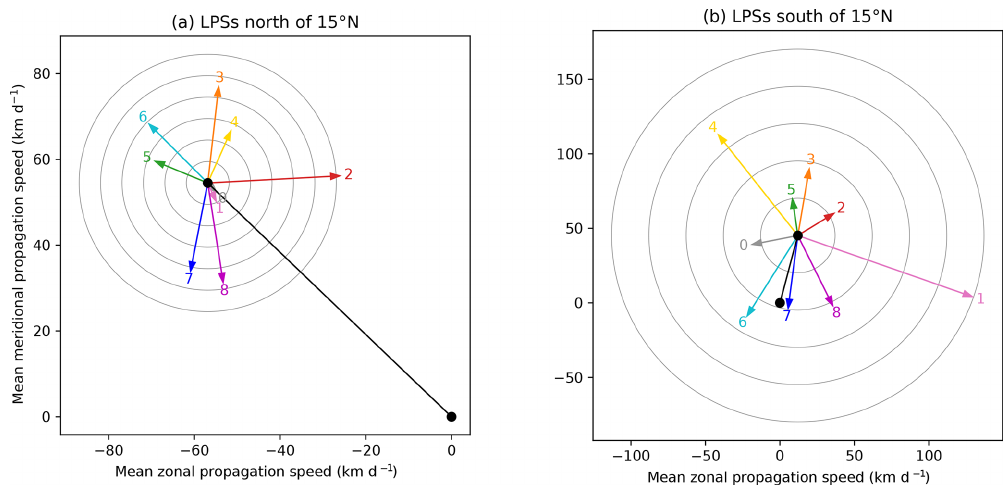
Figure 5. The effect of the BSISO on monsoon LPS propagation velocity for (a) systems north of 15 ◦ N and (b) systems south of 15 ◦ N. In each case, the climatological propagation velocity is given in black, with the anomalies to this mean for each BSISO phase given by coloured arrows. Rings indicate anomalous speeds in multiples of 5 and 25kmd − 1 in (a) and (b)